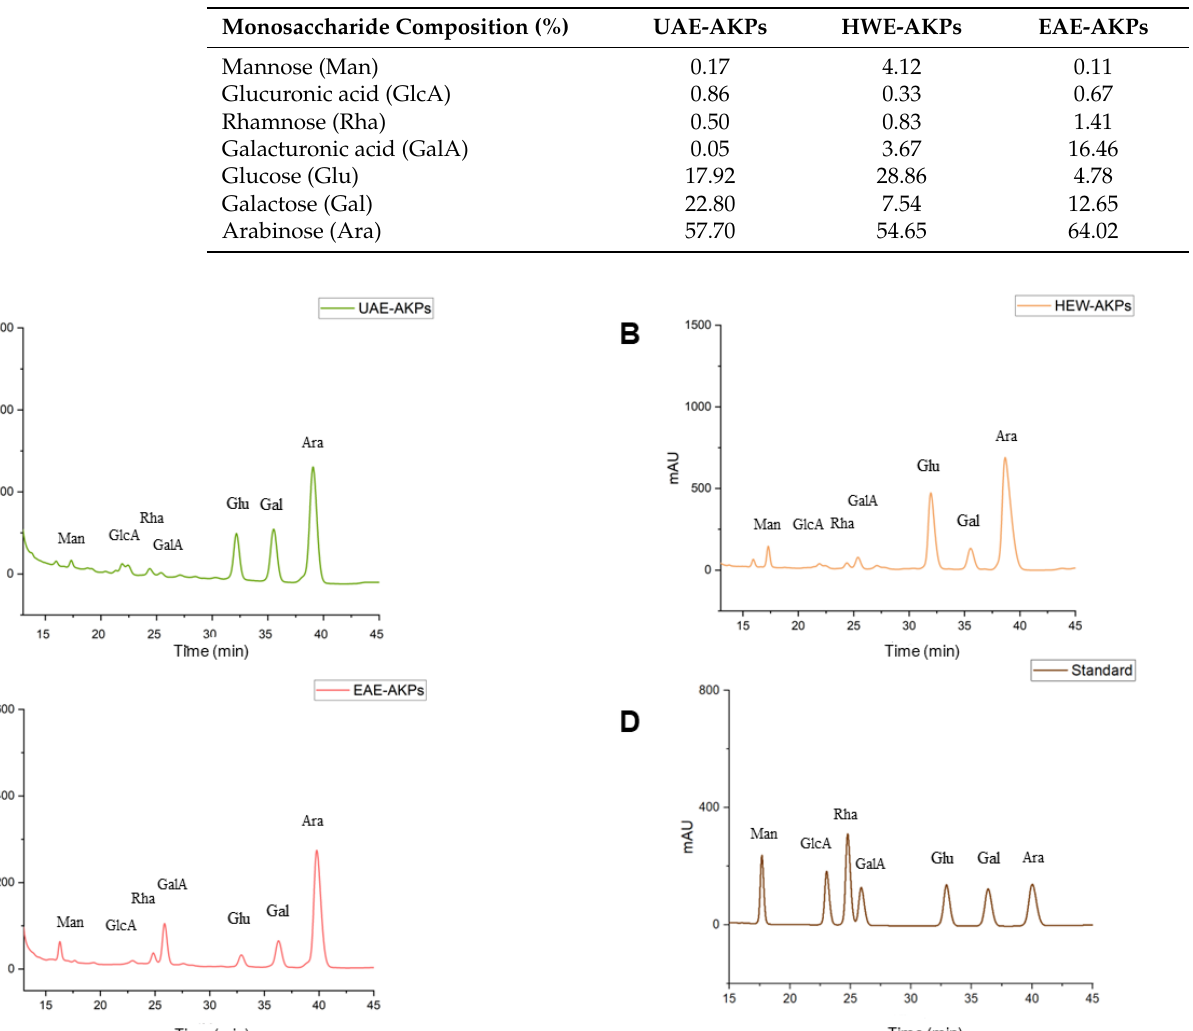
Table 2. The monosaccharide composition of AKPs extracted with three different methods.